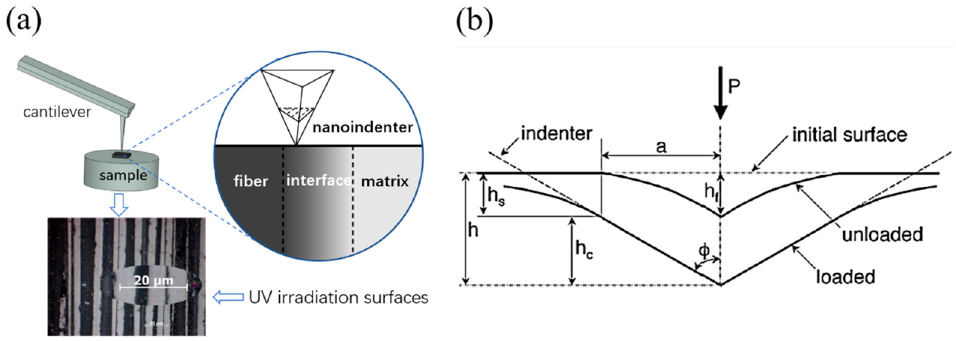
Figure 7. Illustrative descriptions of ( a ) a schematic diagram of nanoindentation test; ( b ) schematic plot of nanoindentation parameters.